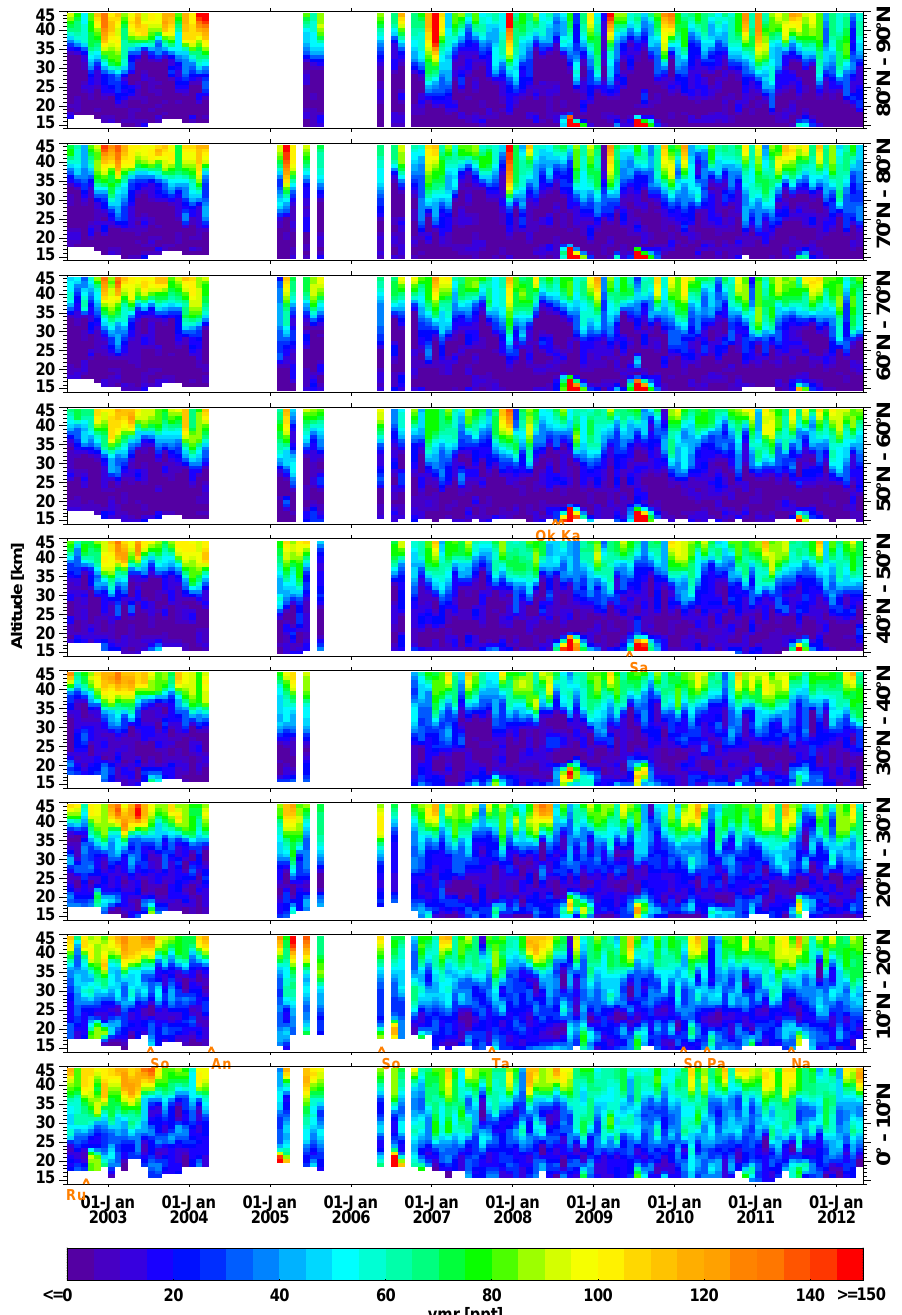
Fig. 5. Same as Fig. 4 but for the Northern